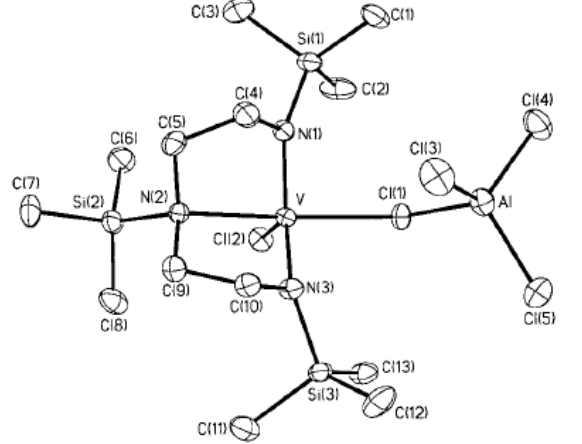
Figure 24. ORTEP plot of V10 . Thermal ellipsoids are drawn at the 30% probability level. Reprinted with permission from [201]. Copyright (2002) American Chemical Society.